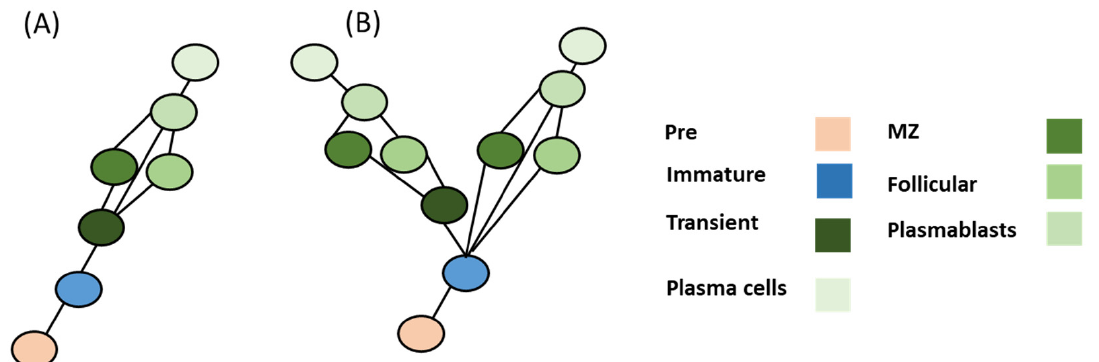
Figure 4. Evolutionary model of B cell differentiation. ( A ) Model A offers a simple homology of a pattern with one unresolved node based on the assumption that transitional B cells were to be localized in sharks. ( B ) Model B assumes that no transitional B cells were to be found in the sharks. This model suggests that MZ and follicular B cells have risen from a convergent or concerted evolution pattern.